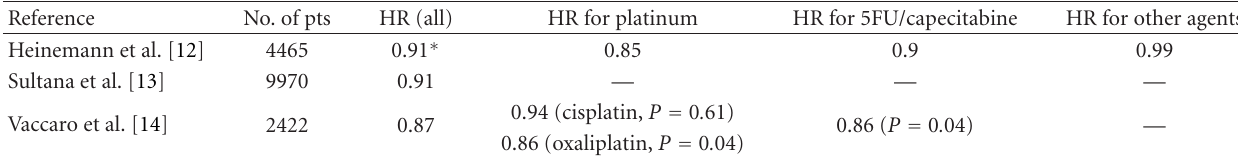
Table 2: Selected metaanalysis of GEM-based combination